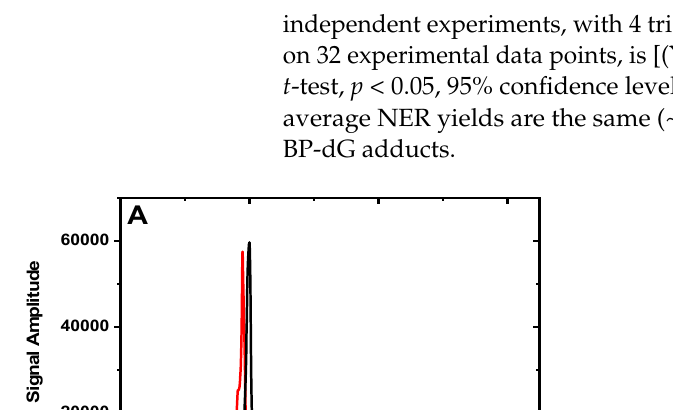
Distance migrated (rel. units)